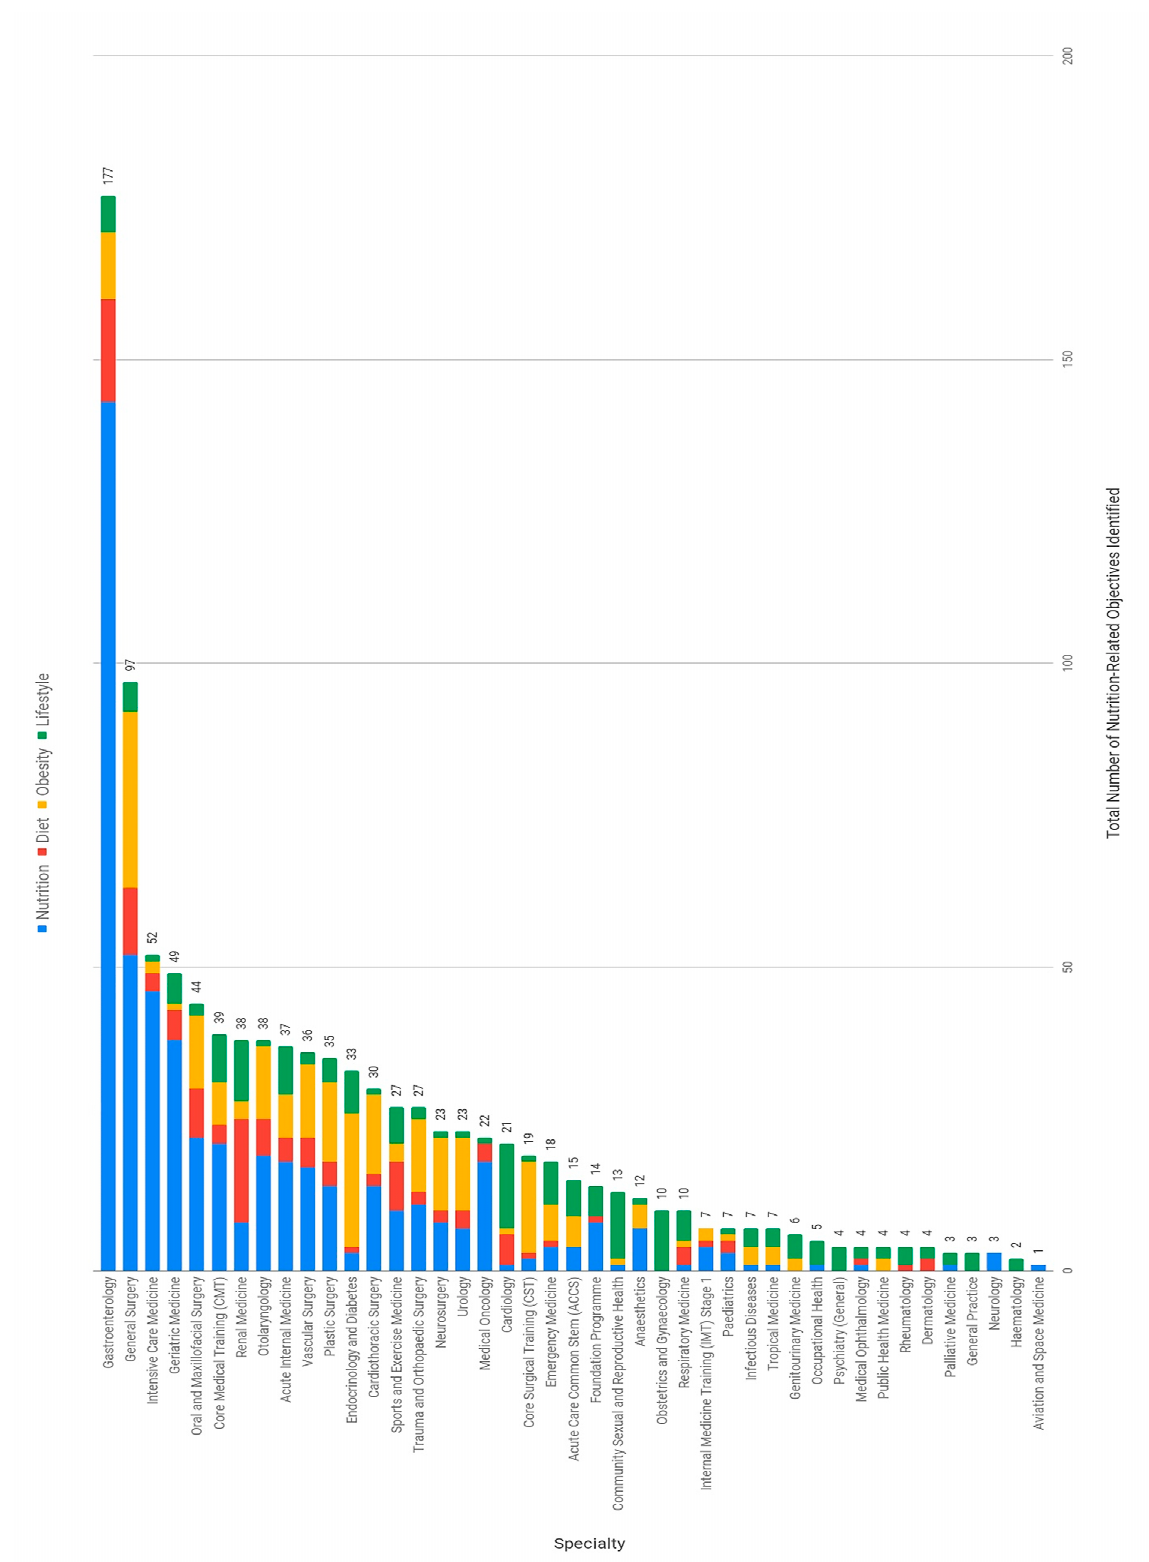
Figure 1. Total number of nutrition-related learning objectives identified per specialty (descending order), and the proportion of keywords used.